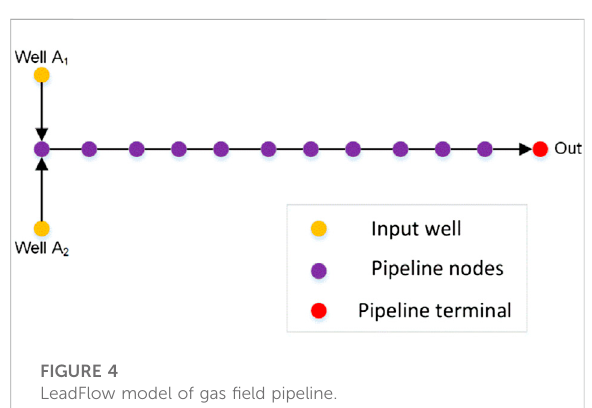
FIGURE 4 LeadFlow model of gas fi eld